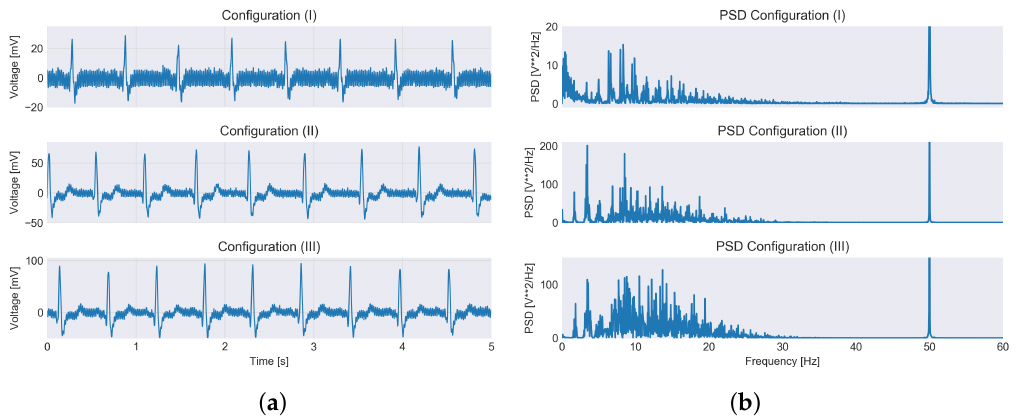
Figure 4. Comparison of measured signal ( a ) and power spectral density (PSD); ( b ) of that signal from our device using different electrode placements. In configuration (I), the measurement electrode was placed on the proximal backside of the right arm wrist. In configuration (II), the measurement electrode was placed on the chest skin at the third intercostal space between the sternum and the midclavicular line. In configuration (III), the measurement electrode was placed on the chest skin at the sixth intercostal space at the midclavicular line. All three configurations show a typical PSD. The heart rate was about 100 beats per minute, thus 1.6 beats per second for case 1 and 3 but was lower for case 2. Thus, peaks can be expected at 1.6 Hz and at the higher order frequencies that are multiples of the 1.6 Hz. This distinct structure gets smeared out when the heart rate variability is large. In case 1, where the signal shows a lower amplitude than when measured at the chest locations, the signal-to-noise ratio is lower and the power of the low-frequency base line fluctuations becomes visible.